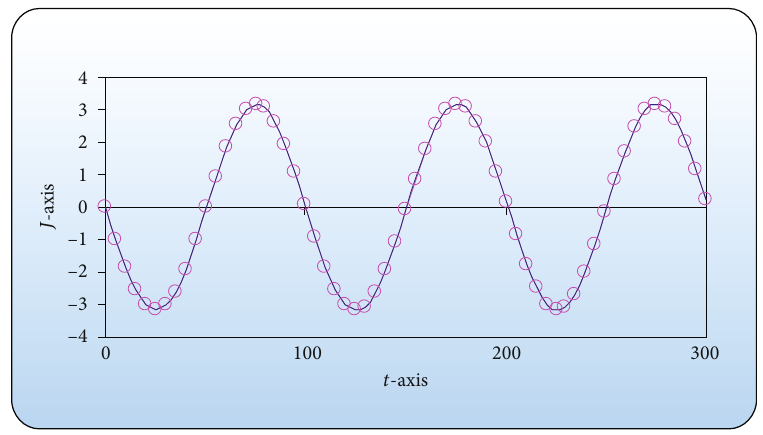
Figure 6: The analytical and numerical solutions J = x